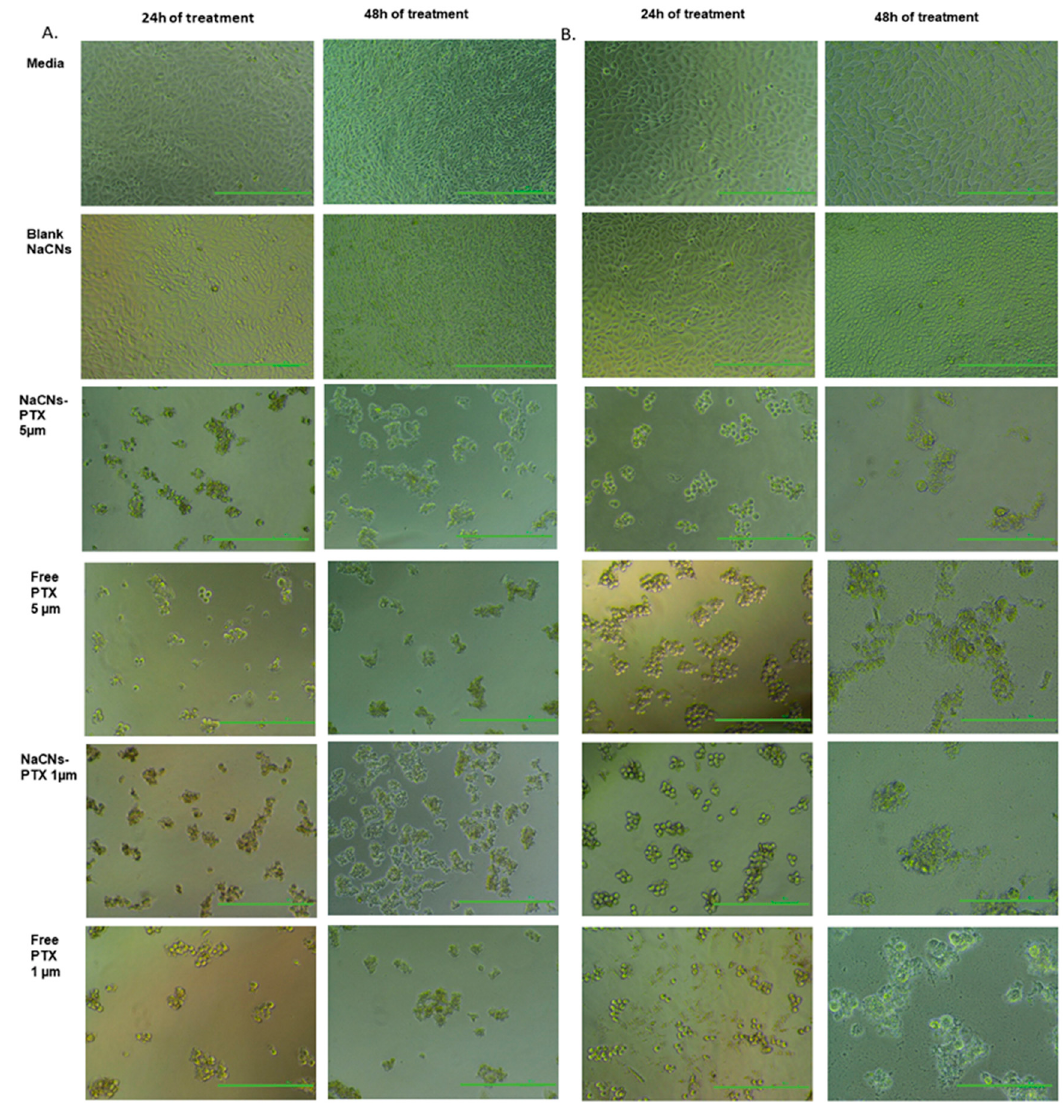
Figure 14. Optical images of ( A ) MCF-7 cells and ( B ) MDA-MB 231 cell lines, treated with control (media), Blank NaCNS, Free PTX and PTX-NaCNs at 1 and 5 μ M (Scale bar: 100 μ m).